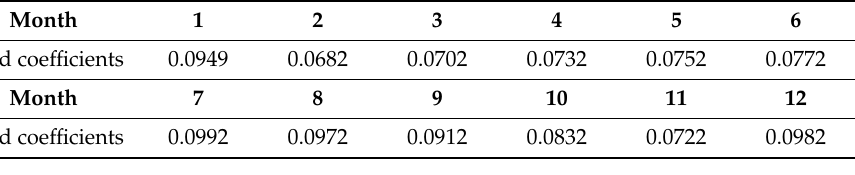
Table 9. The monthly load coefficients.